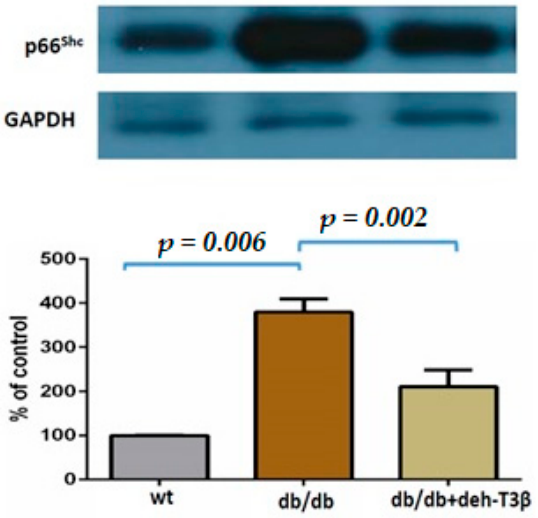
Figure 7. Western blot analysis of p66Shc expression in wt and db/db mice heart. db/db mice were fed with deh-T3 β mixed with the diet for two months.